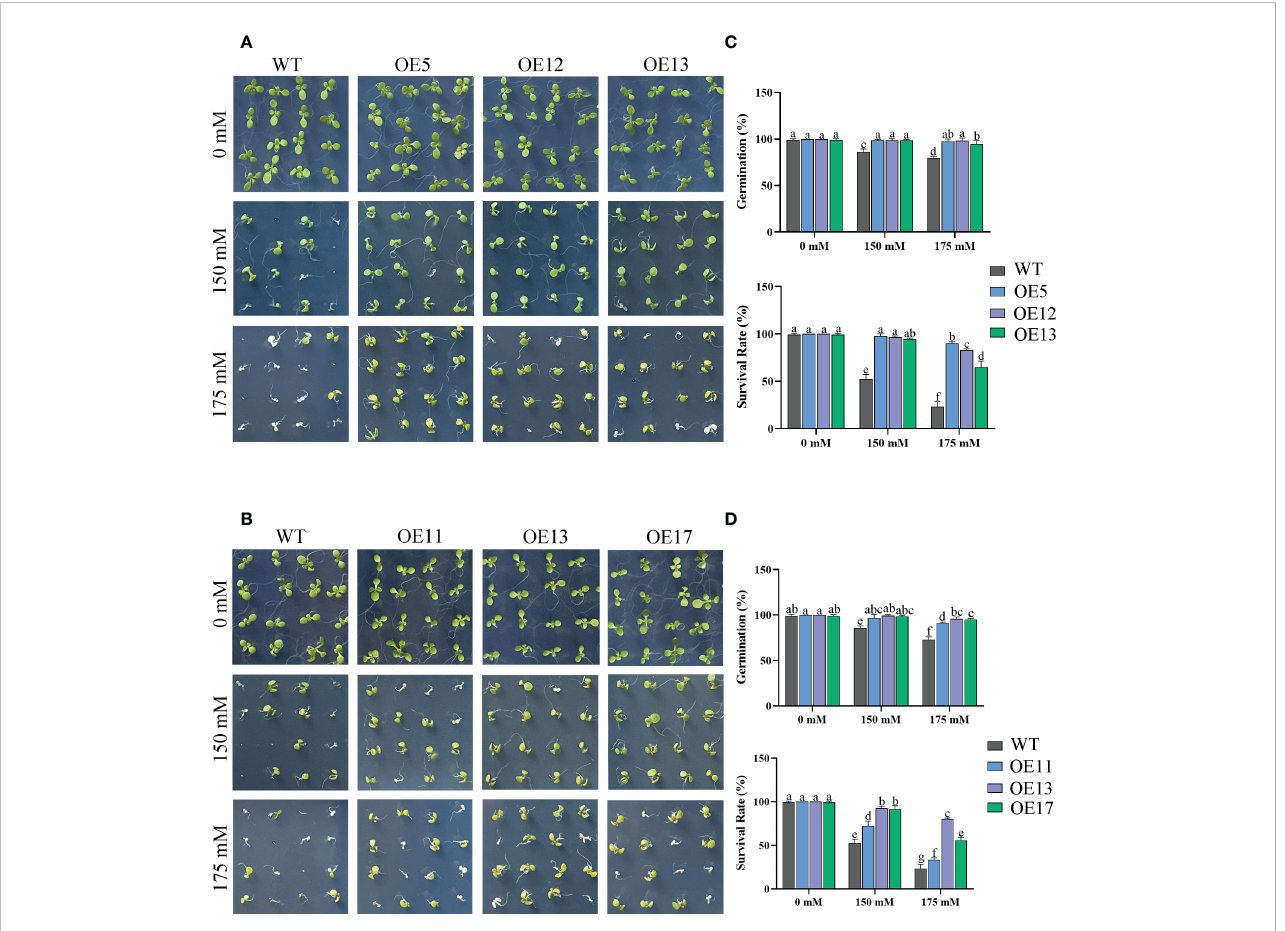
FIGURE 6 Germination of CeqHAK6 and CeqHAK11 transgenic lines under salt stress. (A) Germination of CeqHAK6 transgenic lines under salt stress. (B) Germination of CeqHAK11 transgenic lines under salt stress. Transgenic Arabidopsis seeds and WT seeds were spotted onto 1/2 MS plates with 0, 150, or 175 mM NaCl. (C) Calculation of the germination rates and survival rate of CeqHAK6 -OE and WT seeds. (D) Calculation of the germination rates and survival rate of CeqHAK11 -OE and WT seeds. The signi fi cant differences identi fi ed using Duncan ’ s Multiple Range Test ( p <0.05) were denoted by different lowercase letters on the top of